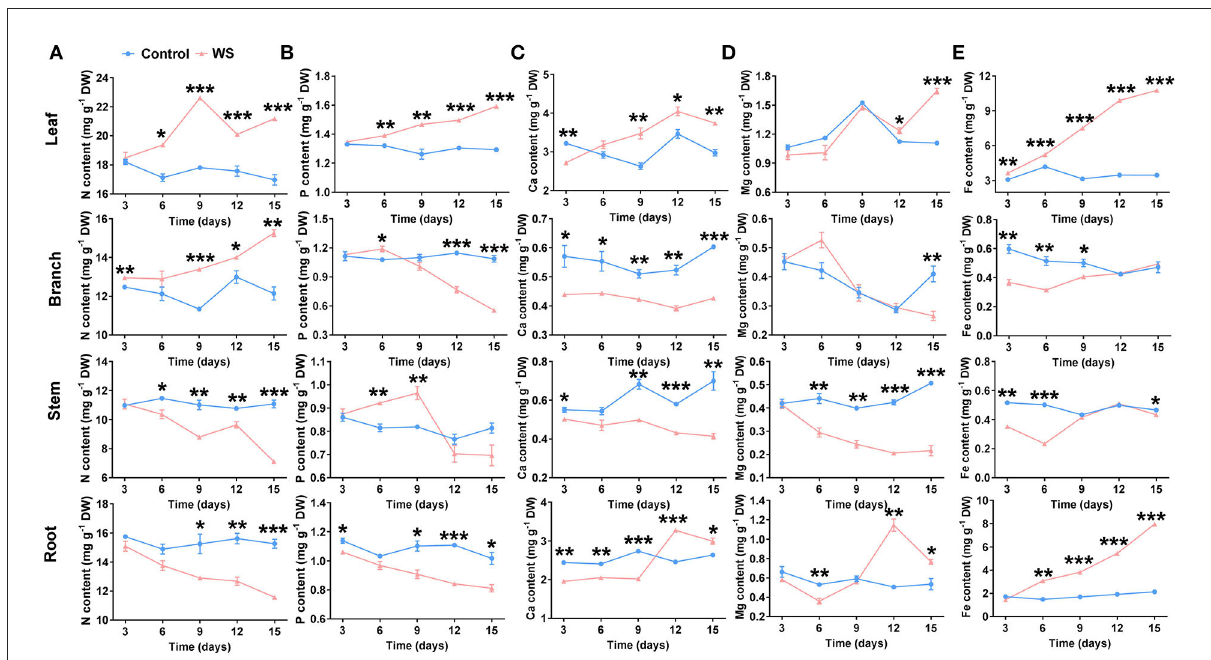
FIGURE2 Effects of waterlogging treatment on the accumulation pattern of N (A) , P (B) , Ca (C) , Mg (D) , and Fe (E) in the leaf, branch, stem, and root of Phyllostachys heteroclada . Data and bars represent the means ± SE of three independent replicates. Asterisks indicate the significant differences between treatments (* P < 0.05, ** P < 0.01, *** P < 0.001, t-test ). WS, Riparian zone waterlogging